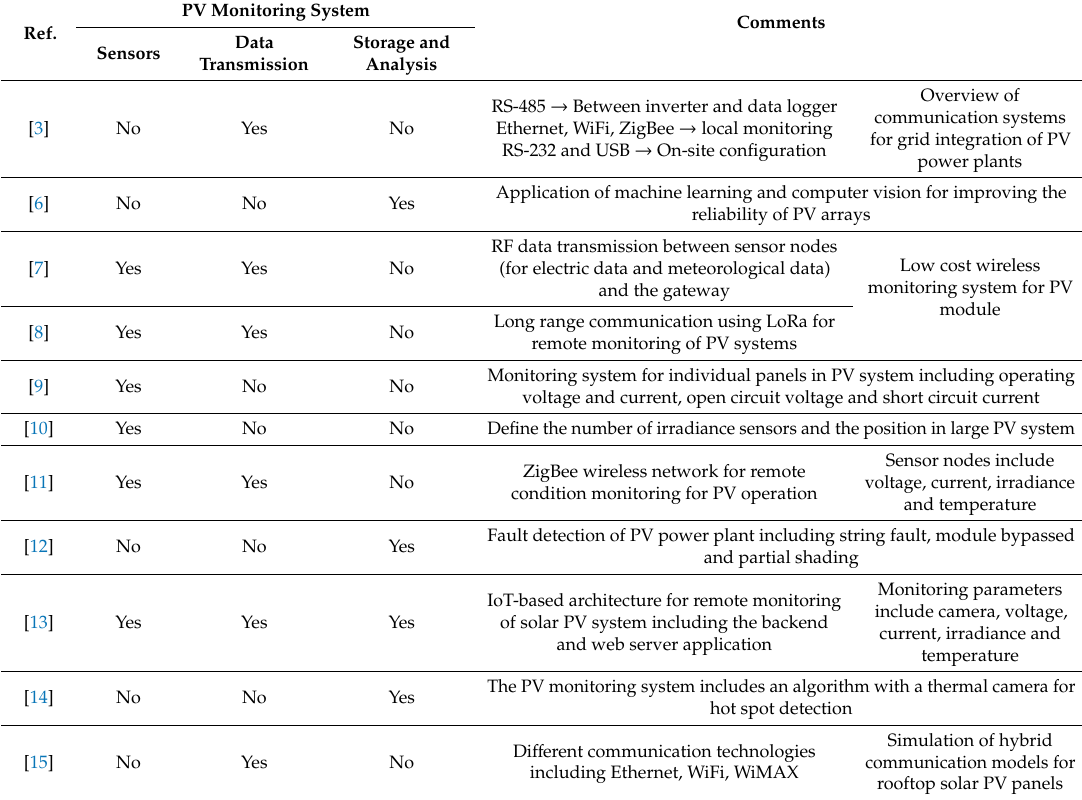
Table 1. Comparison among monitoring system used in photovoltaic (PV) power plant.